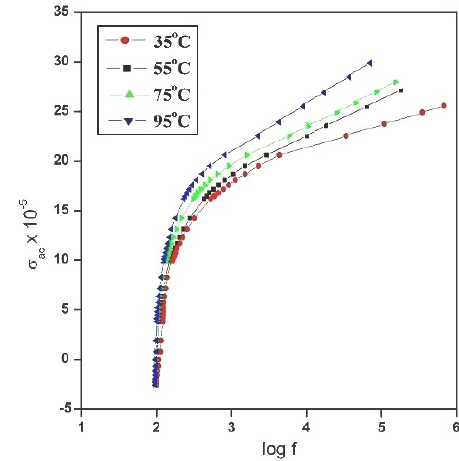
Fig.10. Variation of conductivity with frequency